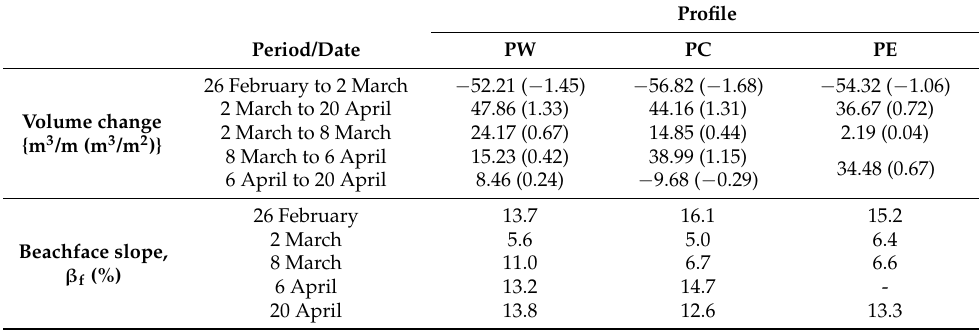
Figure 3. Location of profiles and photos of post-storm beach conditions (PW and PC) ( a ) and measured pre-storm (26 February), post-storm (2 and 8 March) and recovered (6 and 20 April) profiles for PW ( b ), PC ( c ) and PE ( d ; no measurement is available for 6 April). Elevations are relative to mean SL (Cascais vertical datum). Table 1. Volume changes (top panel; values in parentheses refer to m 3 /m per m of profile) and beachface slopes (bottom panel) for the three profiles. Volume changes are given for the erosion phase (26 February to 2 March) and for the recovery period, as a whole (2 March to 20 April), and analyzed in differences between consecutive measured profiles (6 April not measured in PE; the value refers to 8 Mar to 20 April). For consistency, only profile stretches present in all monitored profiles were used for volume calculation (profile lengths of 35.9, 33.8 and 51.2 m for PW, PC and PE, respectively).